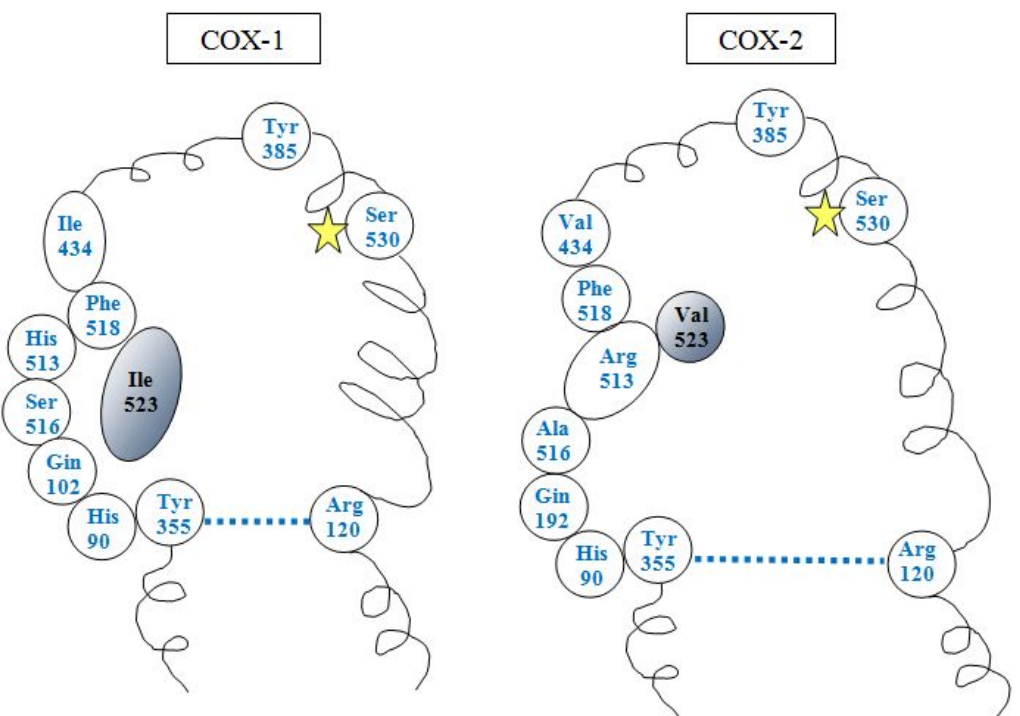
Figure 1. Structure of COX-1 and COX-2